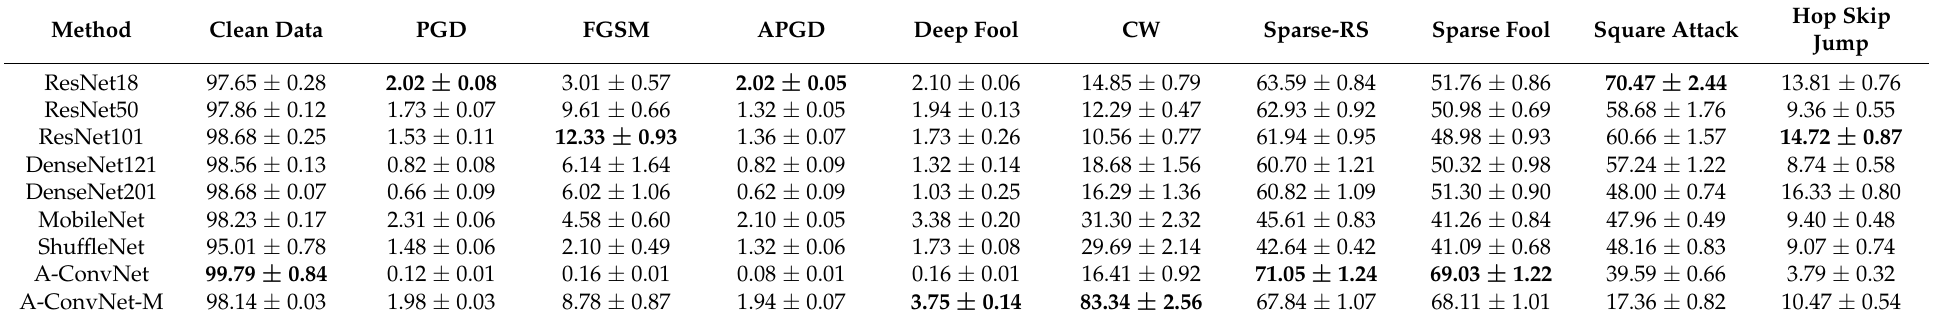
Table 5. Classification accuracy of MSTAR models against different kinds of adversarial attack.